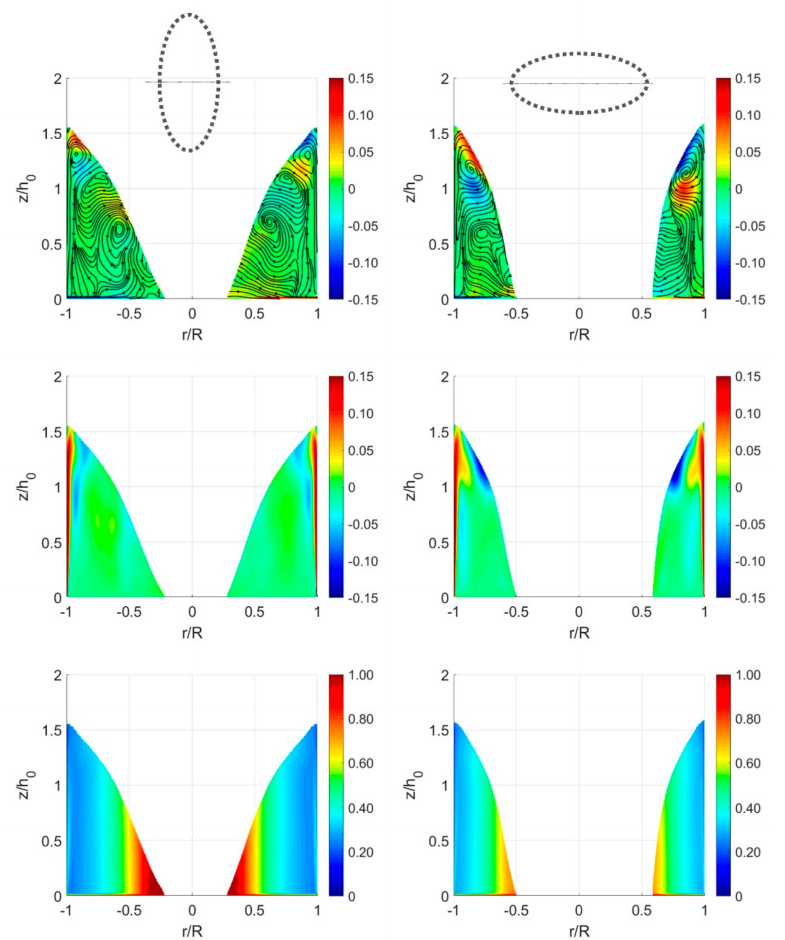
Figure 9. Front view contours of the radial, axial (both in m/s) and normalized tangential velocities in the two vertical cross-sections corresponding to the main axes of the ellipse at the disk rotation frequency of 3.4 Hz. Each velocity field is averaged over 950 frames which represent 95 s of a